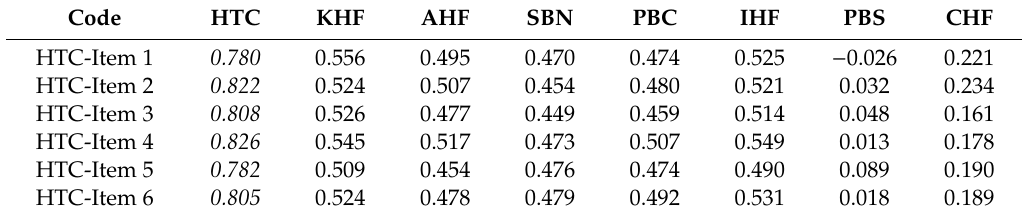
Table 4. Loadings and